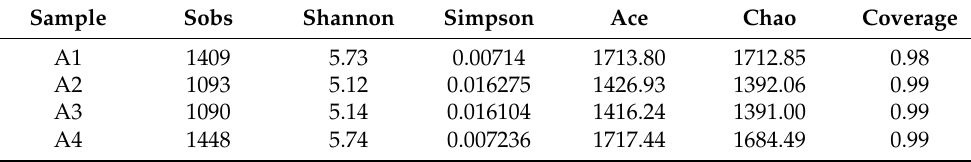
Table 2. Alpha diversity index